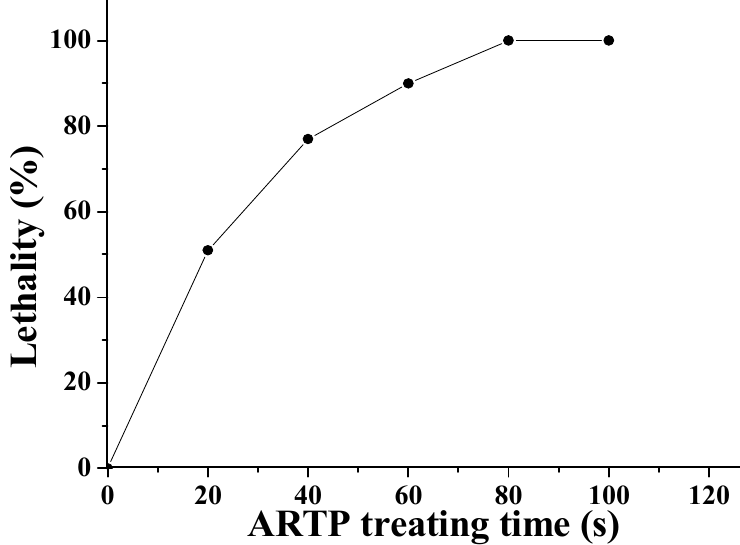
Figure 1. The lethality rate curves of Actinomadura sp. ATCC 39365 under ARTP mutagenesis. 3.2. Screening of High-Yield Pentostatin Mutants with Streptomycin ISP2 medium agar plates containing 0, 5, 10, 15, 20, and 25 mg/L of streptomycin were prepared to determine the sensitivity of Actinomadura sp. ATCC 39365 to strepto- mycin. The lethality rates increased with increasing streptomycin concentration, reach- ing approximately 99.50% when the streptomycin concentration was 20 mg/L, the mini- mum inhibitory concentration of streptomycin for the Actinomadura sp. ATCC 39365 was 20 mg/L (Figure 2).